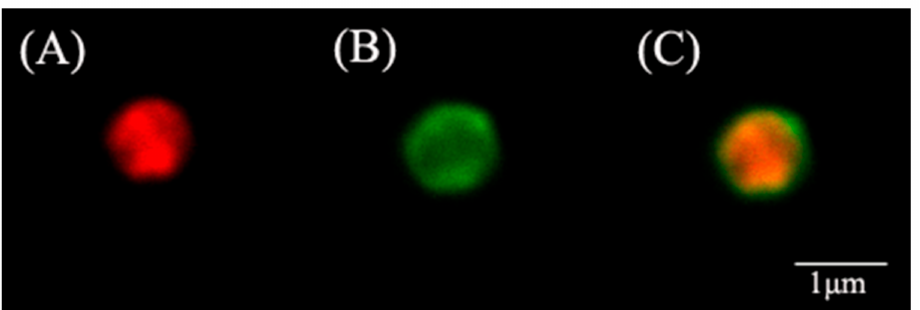
Figure 3. Images of confocal laser scanning microscope. ( A ) Distribution of LDH labeled with Rho- damine B; ( B ) Distribution of ADH labeled with fluorescein isothiocyanate (FITC); ( C ) Distribution of two enzymes in core–shell nanocomposites prepared by ZIF-8 immobilized ADH, LDH, and MSN-NAD